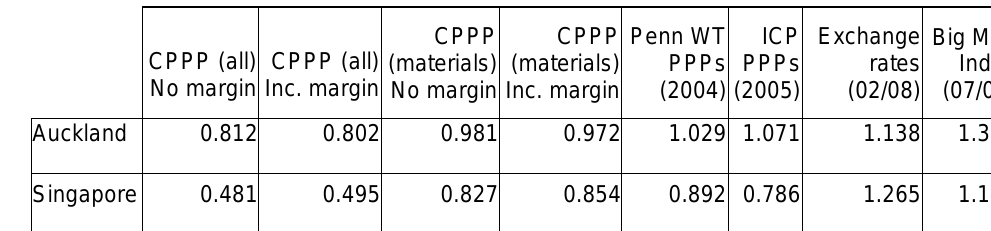
Table 6: Conversion factors relative to